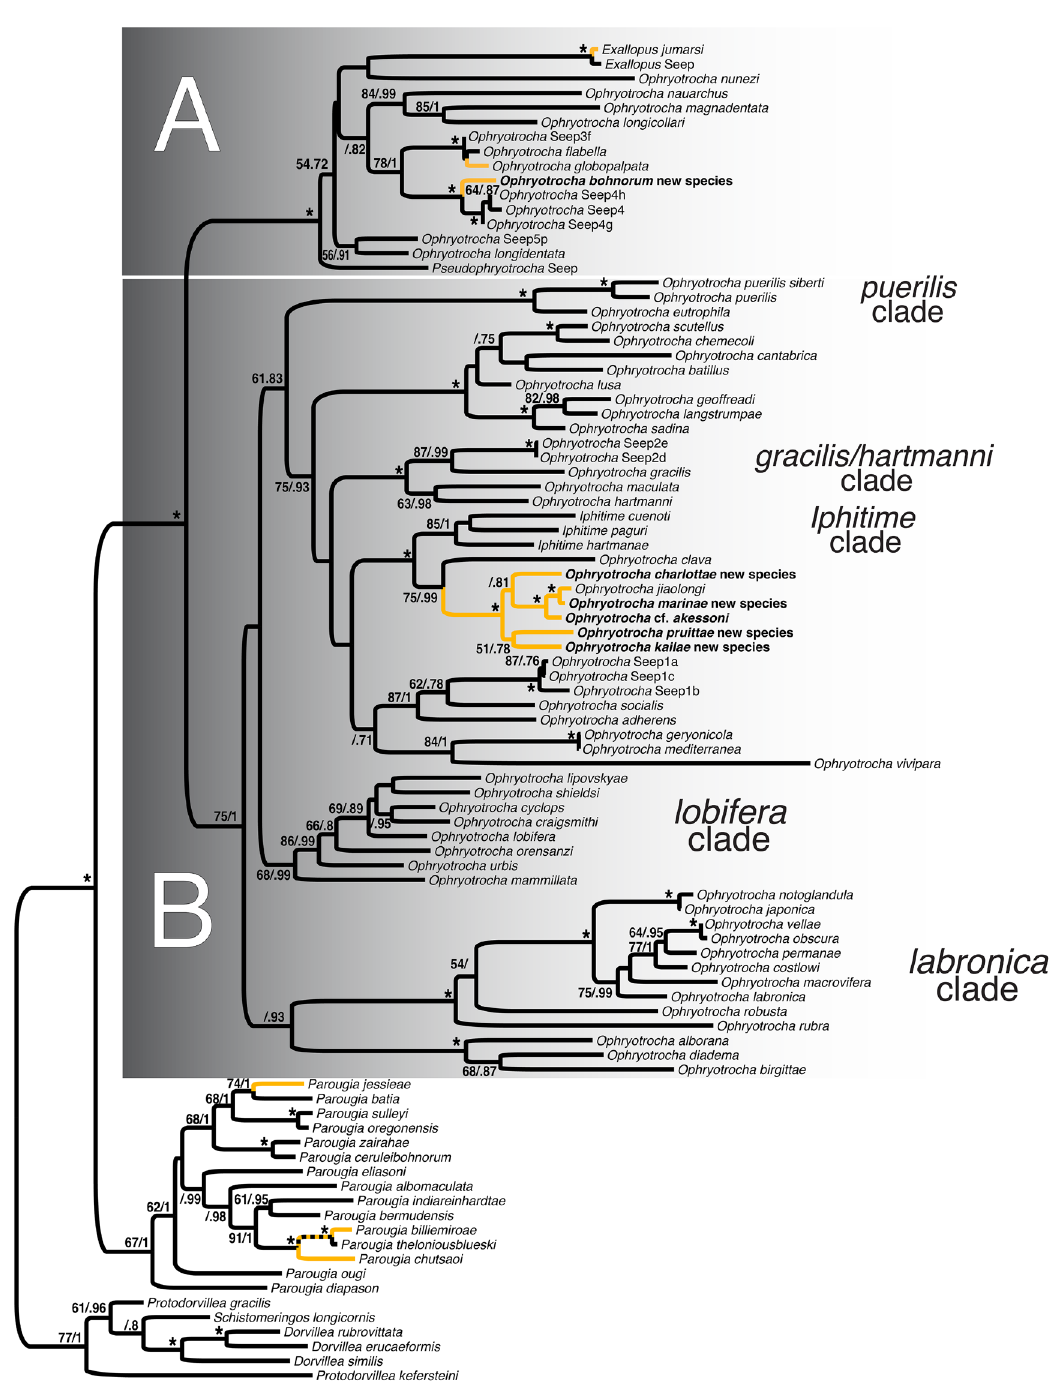
Fig. 1. Phylogenetic tree of Dorvilleidae Ophryotrocha Chamberlin, 1919 based on the Maximum Likelihood and Bayesian Inference analysis of the concatenated dataset of three genes. The outgroup, Eunice pennata (Müller, 1776) is not shown. Numbers on the nodes represent bootstrap support (BS) values followed by posterior probability (PP) values. Blank values indicate BS score of less than 50 or PP of less than 0.7. The * symbol indicated BS support was 95% or greater and PP was 1. Orange branches indicate hydrothermal vent lineages showing that vents have been colonized at least 5 × by Dorvilleidae, 3 × within Ophryotrocha Claparède & Mecznikow, 1869. The letters A and B refer to the two main clades of Ophryotrocha